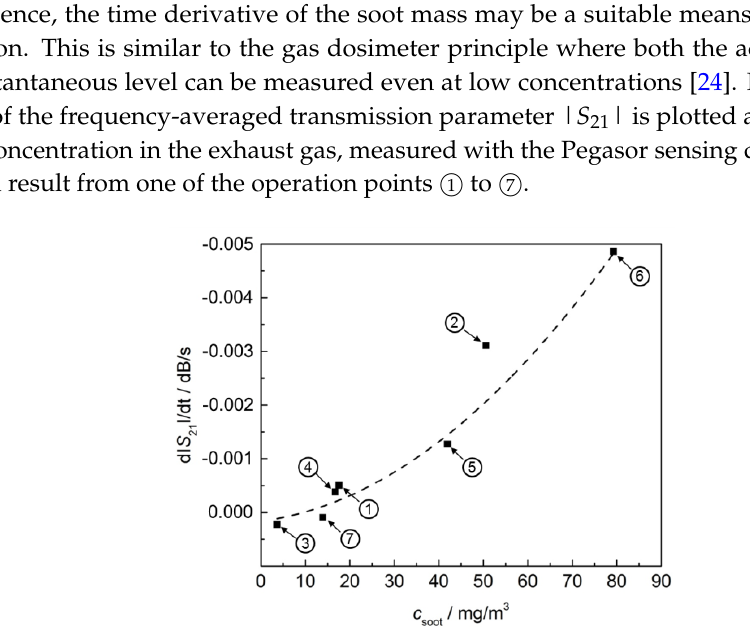
Figure 7. Time derivative of the frequency-averaged transmission parameter | S 21 |over the averaged soot mass concentration in the exhaust upstream of the DPF as determined by the Pegasor sensing device. Each point was obtained from one of the operation points ① to ⑦ , as indicated in Figure 4. The exponential equation d| S 21 |/d t /(dB/s) = 0.24138 · exp(− c soot /(mg/m 3 )/3315.8663) − 0.24062 was used for regression (dashed).